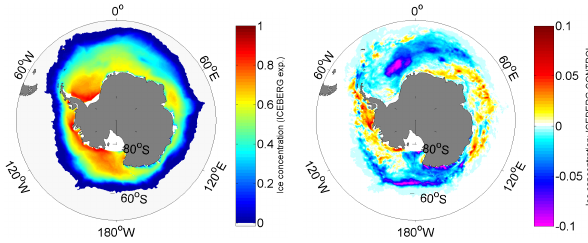
Figure 4. Annual-mean southern hemispheric sea ice concentration averaged for years 26–30, in ICEBERG (left panel), and ICEBERG minus CONTROL differences (right panel).